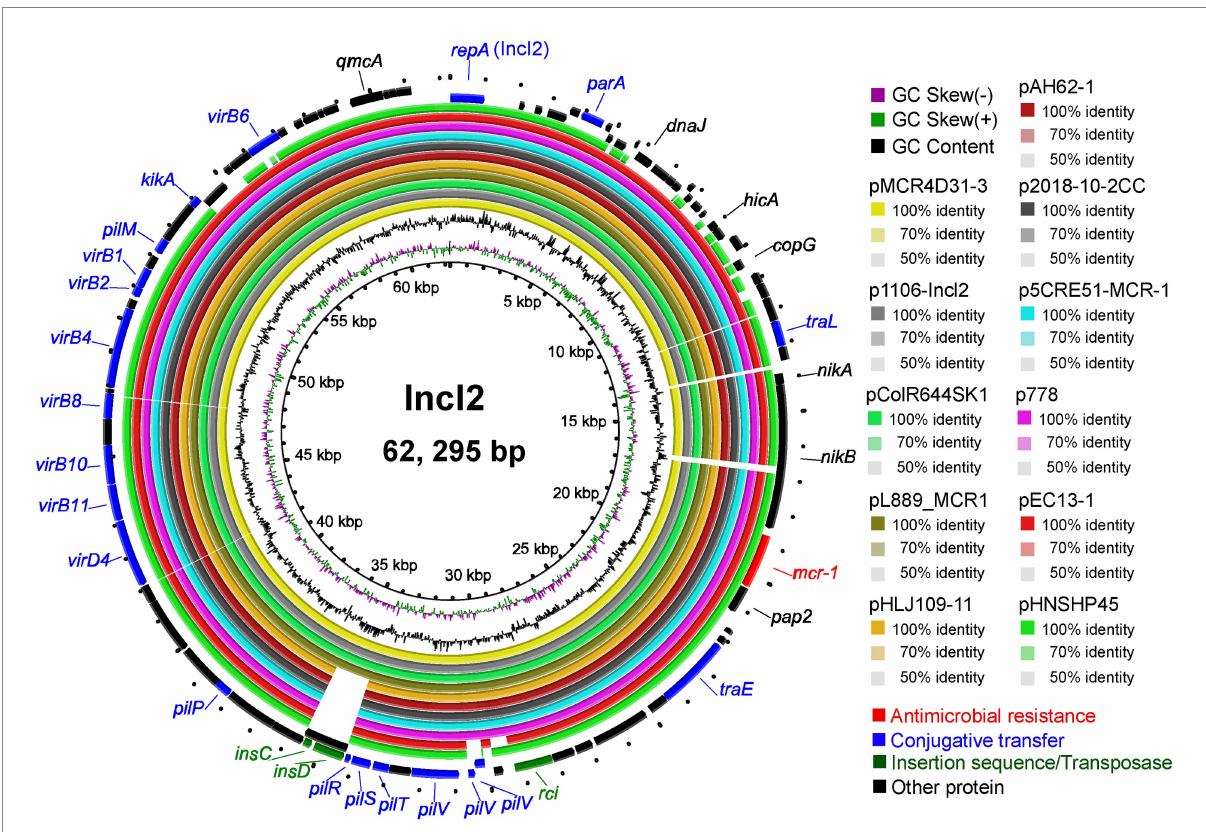
FIGURE 6 Circular diagram of the IncI2 plasmids. Circles, from inside to outside, indicate the GC skew, GC content, and ORFs in the positive and negative DNA strands. Genes are shown in different